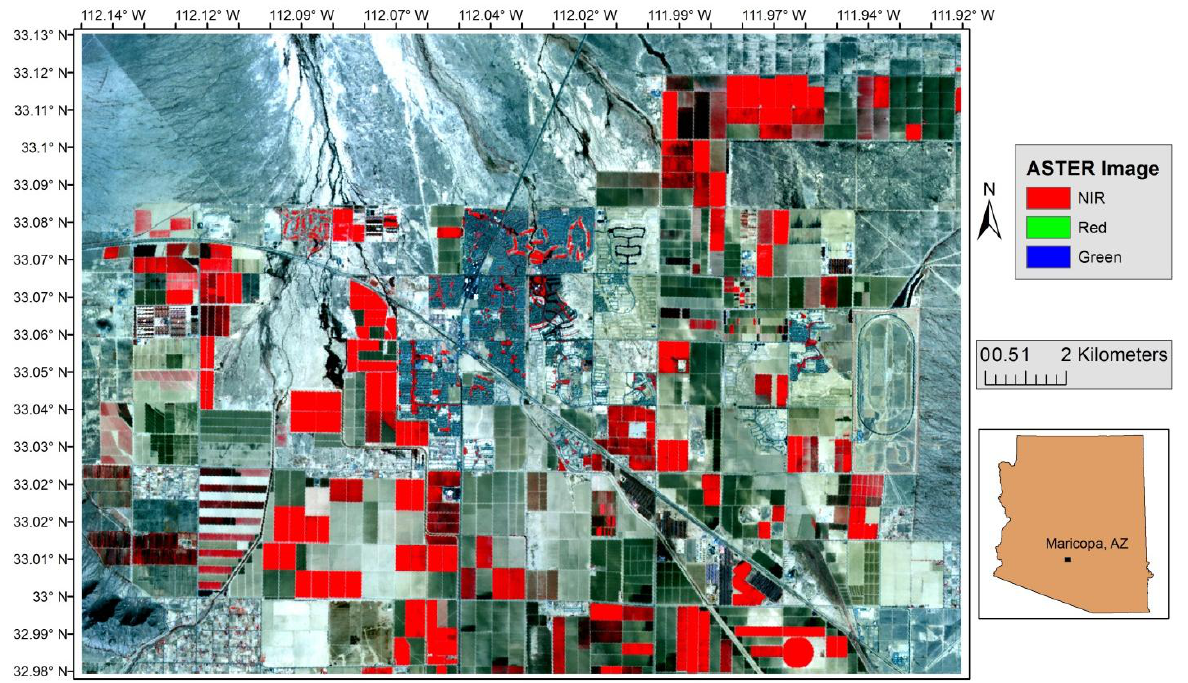
Figure 1. ASTER image of the study area in Maricopa,